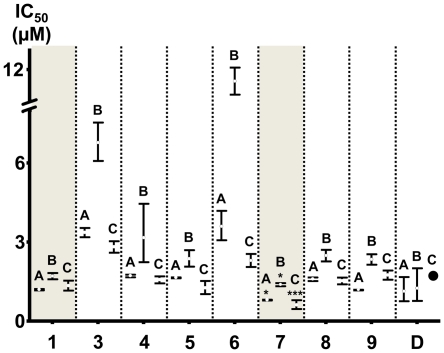

In vitro cytotoxic activities of the protoapigenone analogs against the Hep3B, MCF-7 and MDA-MB-231 cell lines.Numbers on the abscissa represent the corresponding compounds, while charts A, B and C represent activities against Hep3B, MCF-7 and MDA-MB-231 cell lines, respectively. Error bars represent the 95% confidence intervals of the IC50 values; doxorubicin: ambiguous fitting, no confidence interval available. Significantly stronger activities comparing to that of 1 are marked; *: p<0.05 by unpaired T-test; ***: p<0.001 by ANOVA.